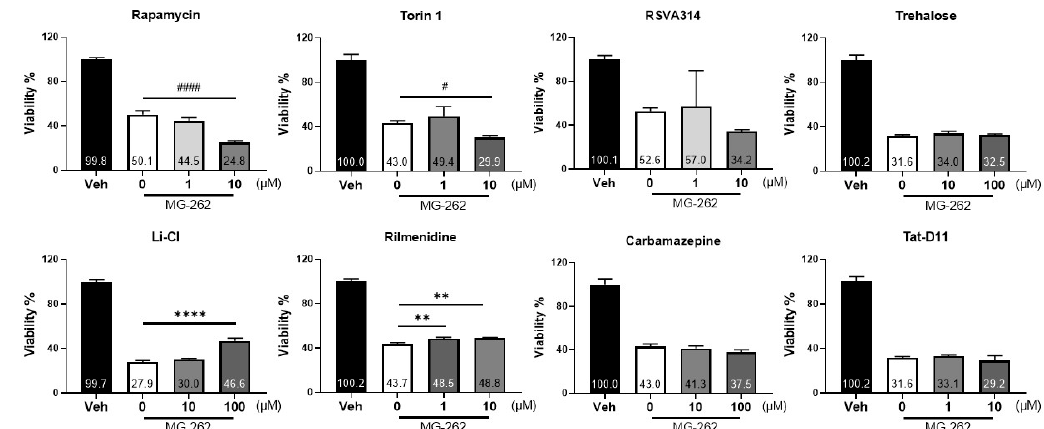
Figure 5. Autophagy activators could alleviate MG-262-induced cytotoxicity. Human neuroblastoma cells, SH-SY5Y, were treated with a series of different autophagy activators, as indicated, 1 h prior to treatment with 0.2 µM MG-262 or its vehicle (0.1% dimethyl sulfoxide in Dulbecco’s Modified Eagle’s Medium) for 24 h, and cell viability was measured by WST-1 assay. All experiments were performed in triplicate and each value is shown as a percentage of that obtained in the vehicle group. Statistical test was performed with one-way analysis of variance, followed by Dunnett’s post hoc test. Each value represents the mean ± standard deviation with the mean value indicated at the bottom of each bar. ** p < 0.01, **** p < 0.0001, statistically significant increase in cell viability compared with the respective vehicle group; # p < 0.05; #### p < 0.0001, statistically significant reduction in cell viability compared with the respective vehicle group.